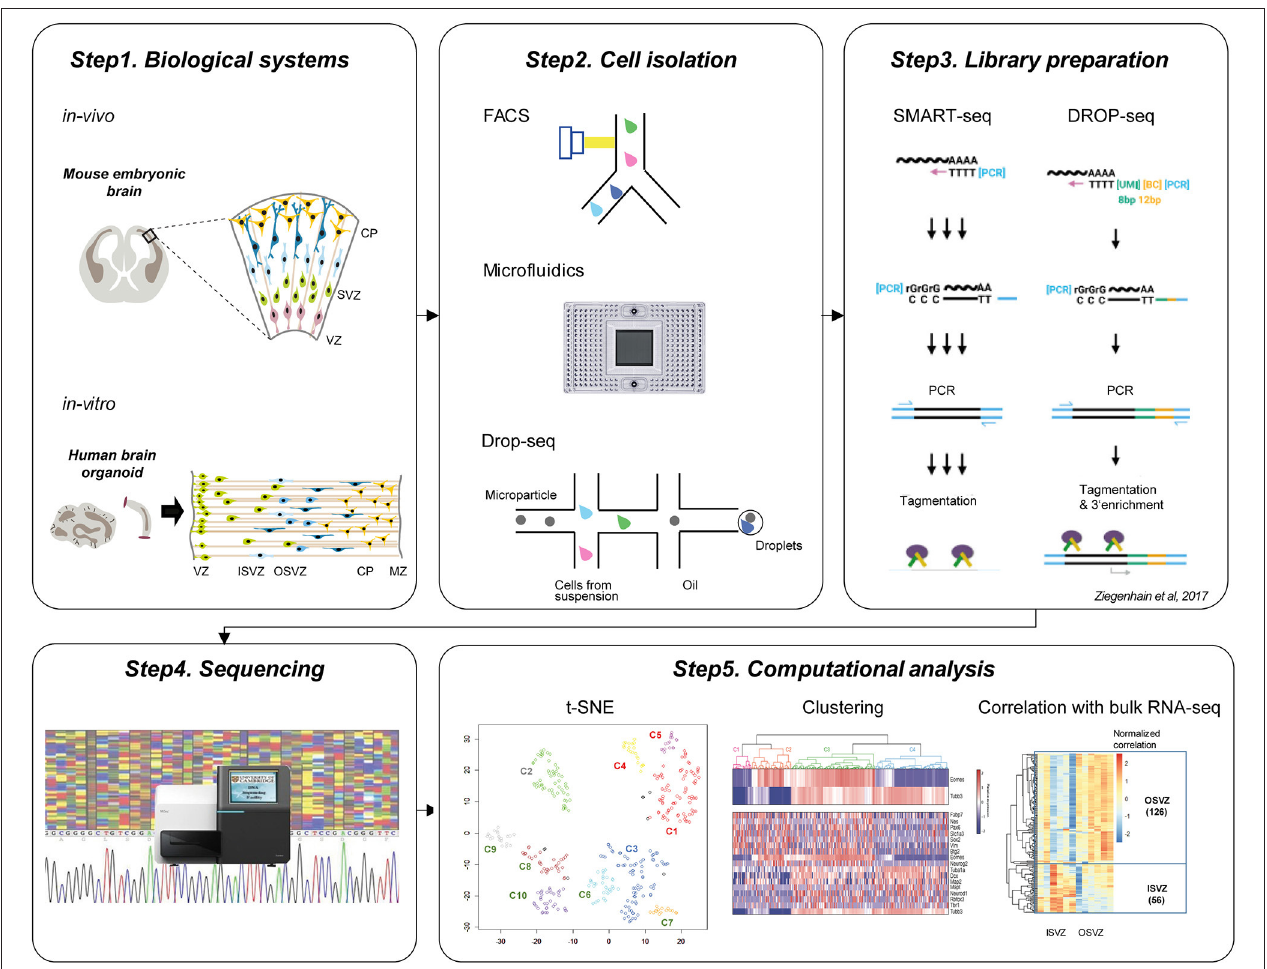
FIGURE 1 | Current workflow of single-cell technologies to study cortical development. Step1. Biological systems to study brain development. Upper panel shows in vivo mouse embryonic brain and below panel indicates in vitro human brain organoid which is commonly used for the single-cell neurogenesis studies. Step2. Cell isolation methods. Individual cells can be isolated using FACS, Microfluidic ChIP, or Drop-seq approaches. Step3. Library preparation. The common protocols include polyA + mRNA capture, reverse transcription, cDNA amplification using PCR, and tagmentation. Step4. Sequencing of the library. Step5. Computational analysis. After the preprocessing of sequencing reads, visualization using t-SNE, unsupervised clustering, and correlation analysis with bulk RNA-seq is followed to identify subtypes of cells and characterize their